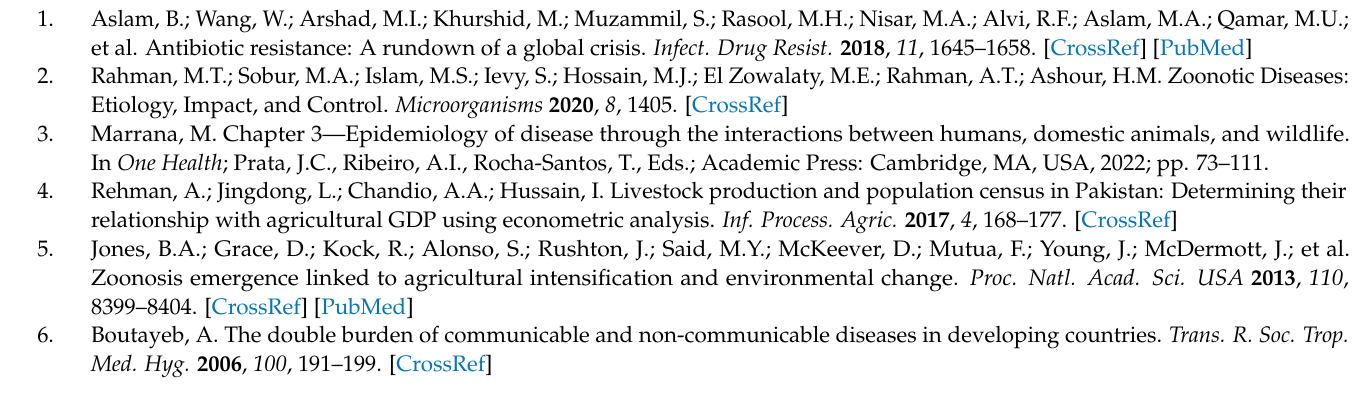
Table S5: Primer sets used in the study. Figure S1: Clustering of E. coli strains from human (a), animal (b) and environmental (c) origins based on antimicrobial susceptibility patterns. Figure S2. Heatmap showing the virulence genes profiles of all E. coli strains. Figure S3: Distribution of E. coli pathotypes among human, animal and environmental origins and sources. Figure S4: Association of pathotypes with antimicrobial resistance profiles ( p -value 0.08). Figure S5: ERIC-PCR fingerprints based dendrograms of human (a), animal (b), environmental (c) strains based on Dice similarity coefficient